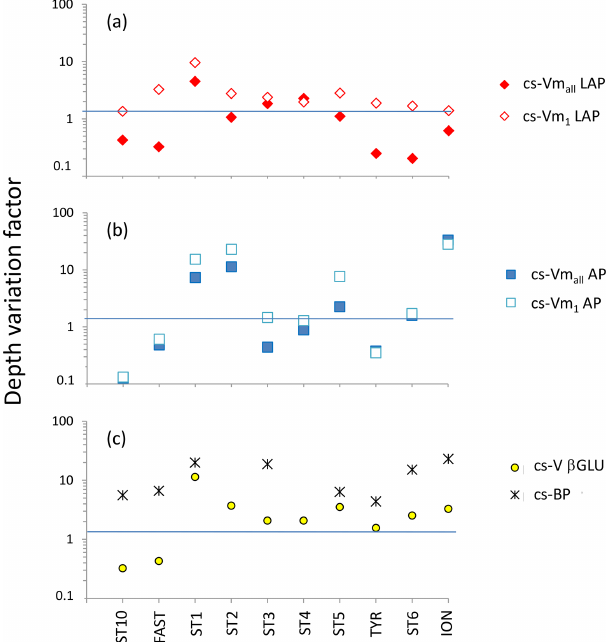
Figure 9. Depth variation factor (DVF; unitless) for ectoenzymatic specific activities. DVF is calculated as the mean of pooled data from the SURF and DCM layers divided by the mean of pooled data from the LIW and MDW layers. (a) DVF of cell-specific leucine aminopeptidase (cs-Vm all and cs-Vm 1 ); (b) DVF of cell-specific alkaline phosphatase (cs-Vm all and cs-Vm 1 ); (c) for β -glucosidase DVF, cell-specific activities are based on the few detectable rates at high concentration (yellow dots). Black crosses show the DVF of cell-specific heterotrophic prokaryotic production